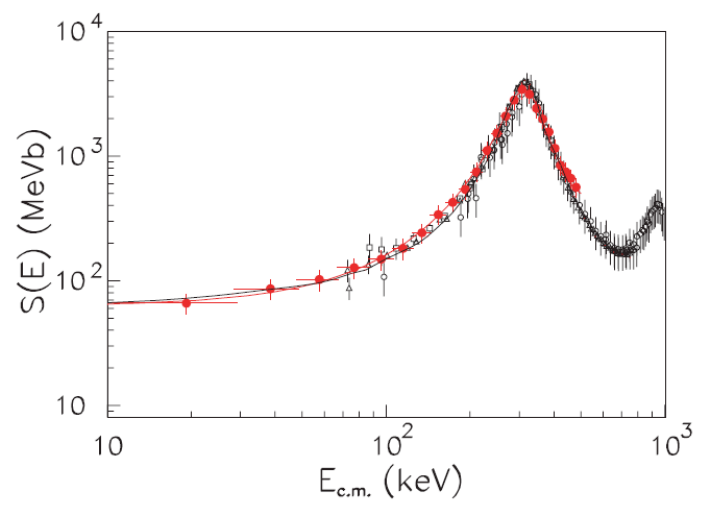
Figure 7. THM S(E)-factor is shown as full red dots. The direct data from [96–98] are also shown as open symbols (circles, squares, and triangles, respectively). The red line represents a fit to the THM data. The black line is the result of the Breit–Wigner parametrization reported in